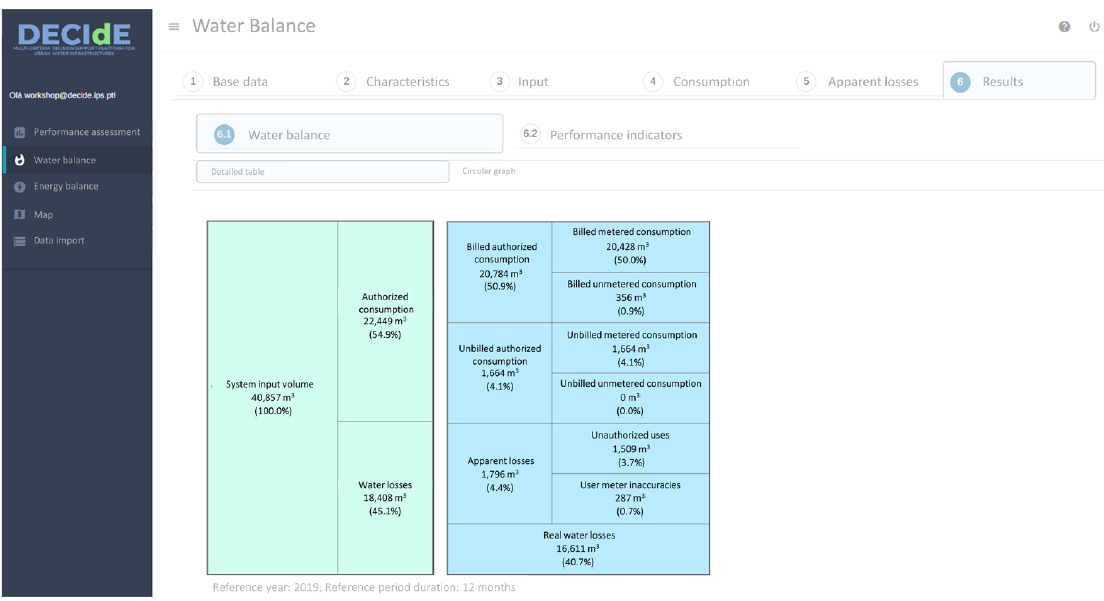
Water 2023 , 15 , x FOR PEER REVIEW Figure 1. Screenshot of the window of data integration in the DECIdE platform. Figure 1. Screenshot of the window of data integration in the DECIdE platform.